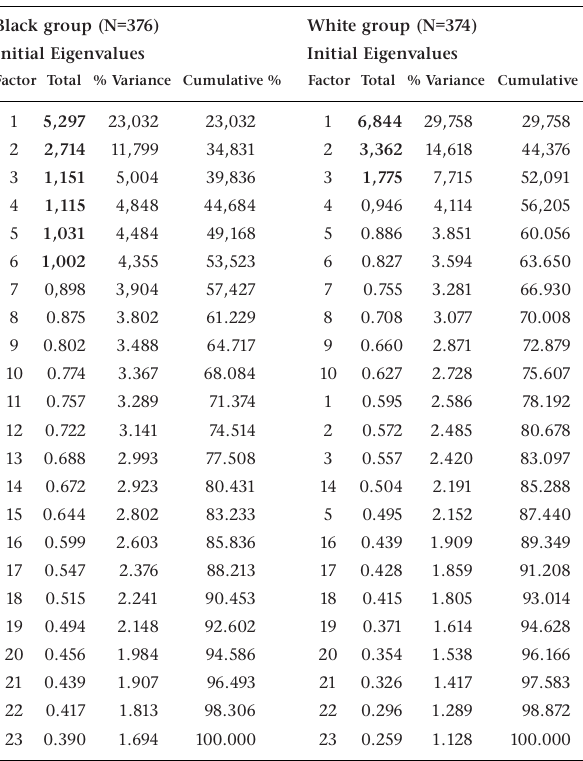
Figure 1: Scree-plot (Black group) T ABLE 7 F ACTOR EIGENVALUES AND VARIANCE EXPLAINED FOR BLACK AND WHITE GROUPS Black group (N=376)